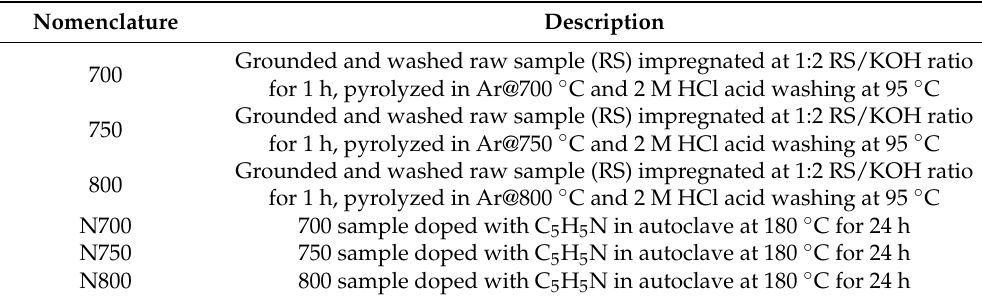
Table 1. Nomenclature to identify the synthesized